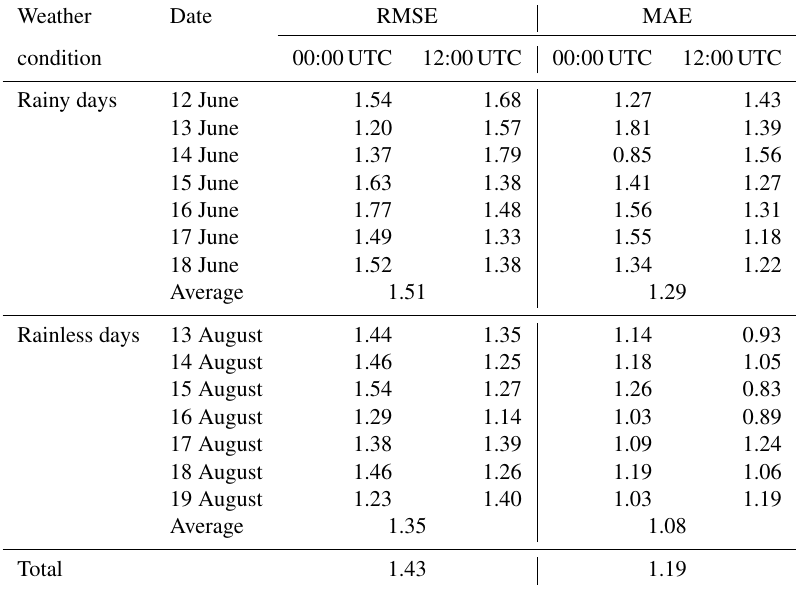
Table 2. RMSE and MAE of the water vapour density comparison between radiosonde and tomography based on the genetic algorithm for different weather conditions (gm − 3